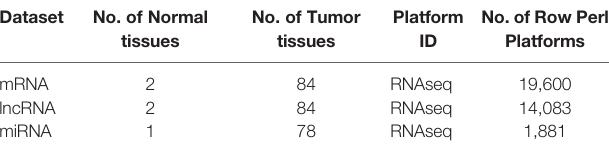
TABLE 2 | Basic information on the ceRNA network.